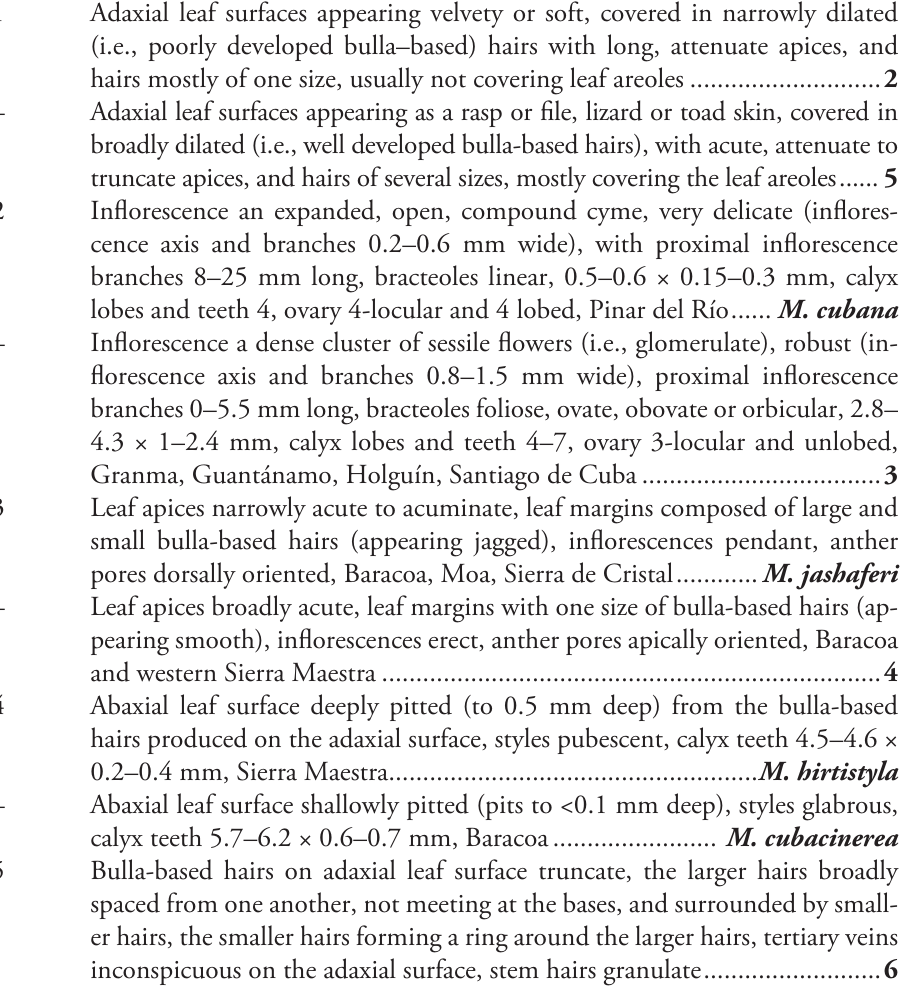
Bulla-based hairs on adaxial leaf surface truncate, the larger hairs broadly spaced from one another, not meeting at the bases, and surrounded by small- er hairs, the smaller hairs forming a ring around the larger hairs, tertiary